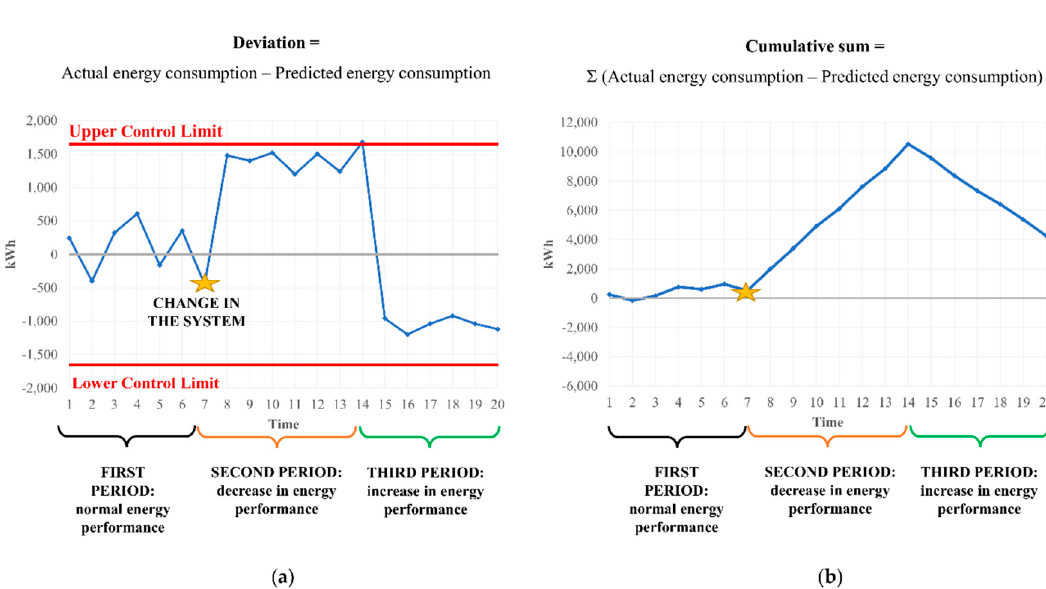
Figure 3. Qualitative representation of the two control charts applied for the joint analysis of energy behavior of a system: ( a ) control chart for energy performance deviations and ( b ) the cumulative sums chart (CuSum) chart. In the first period of the analysis (time interval from 1 to 7) the energy behavior of the system is normal, whereas in the second period (time interval from 7 to 14) the charts show a decrease in energy performance (positive shift of the average in ( a ) and upward trend in ( b )). In the final period (time interval from 14 to 20), the system shows an improvement of the performance (negative shift of the average in ( a ) and downward trend in ( b )).